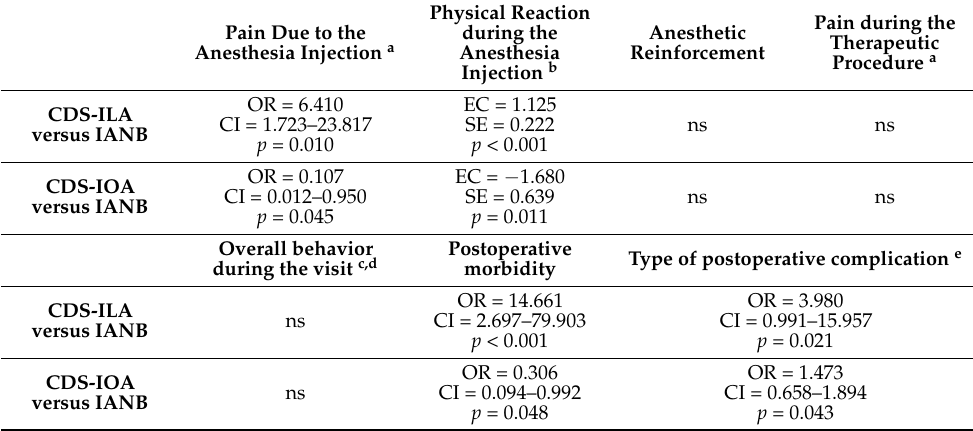
Table 3. Computer delivery system—intraligamentary anesthesia (CDS-ILA) or computer delivery system—intraosseous anesthesia (CDS-IOA) versus inferior alveolar nerve block with conventional syringe (IANB). Strength of the relationship in the proposed model between exposure to an anesthesia system and the outcome